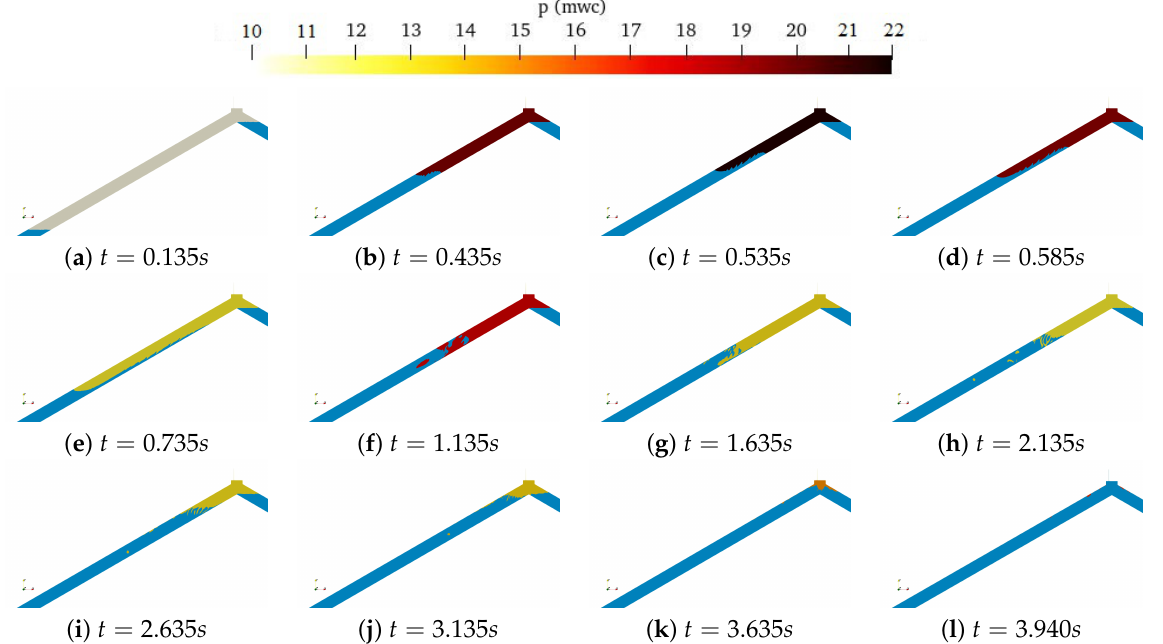
Figure 8. Behaviour of p in the air pocket during the filling process throughout its complete